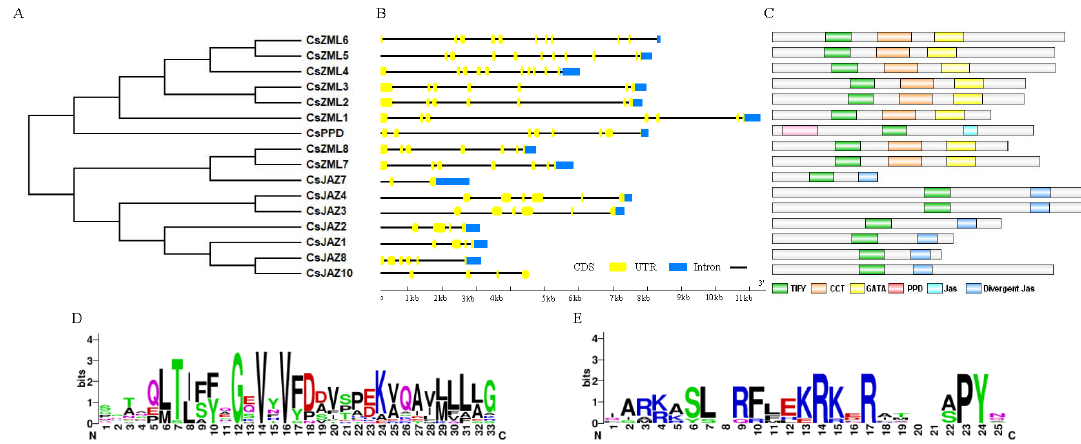
Figure 3. Sequence analysis of TIFY in tea plant. ( A ) Phylogenetic analysis of CsTIFY proteins. The phylogenetic tree was performed in MEGA5.1 software with the neighbor-joining method. ( B ) Exon / intron structure of CsTIFY genes. Exons and introns were represented by yellow boxes and black lines, respectively. ( C ) The distribution of conserved domains in CsTIFY proteins. Each domain was represented by a colored box. Sequence logos of the TIFY ( D ) and Jas ( E ) domains from CsTIFY proteins.